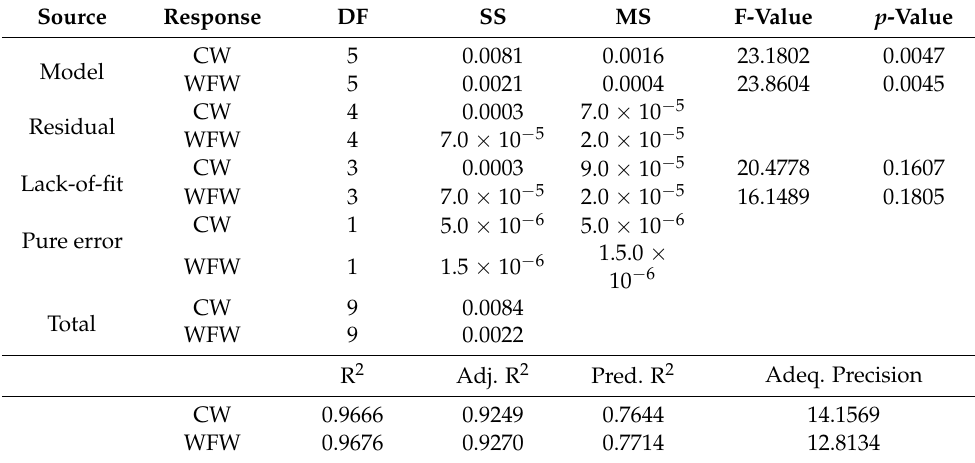
Table 5. Analysis of variance (ANOVA) for settling velocity.